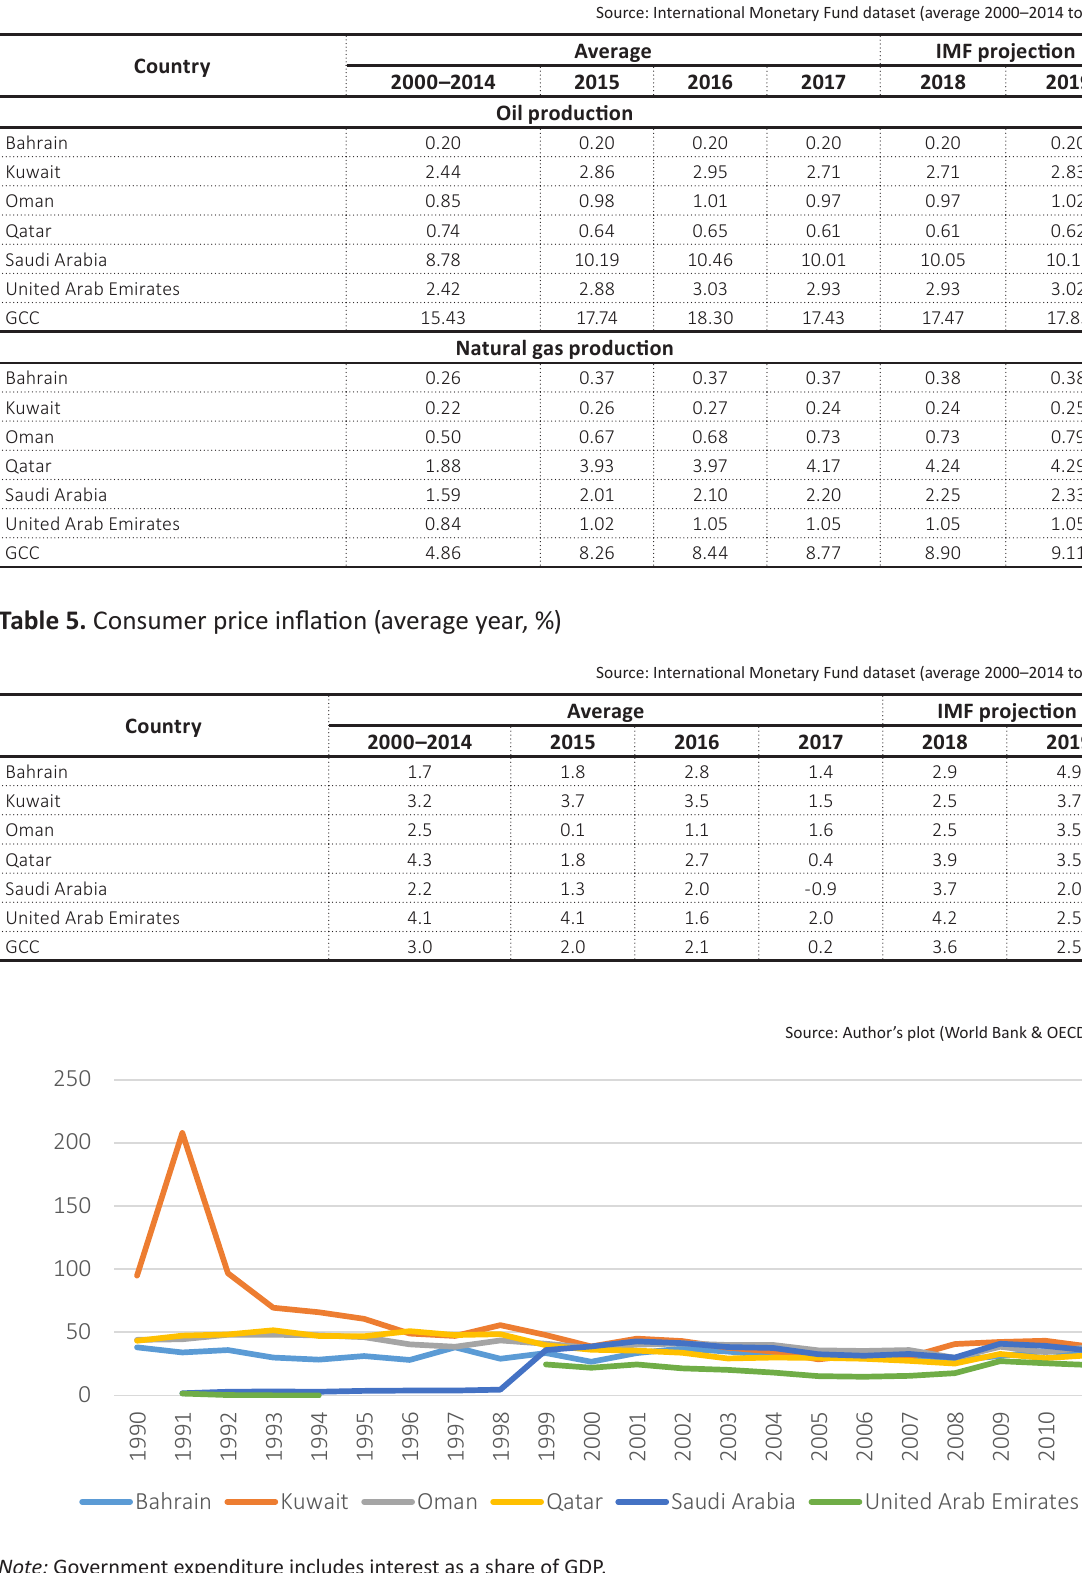
Figure 3. Government expenditure (% of